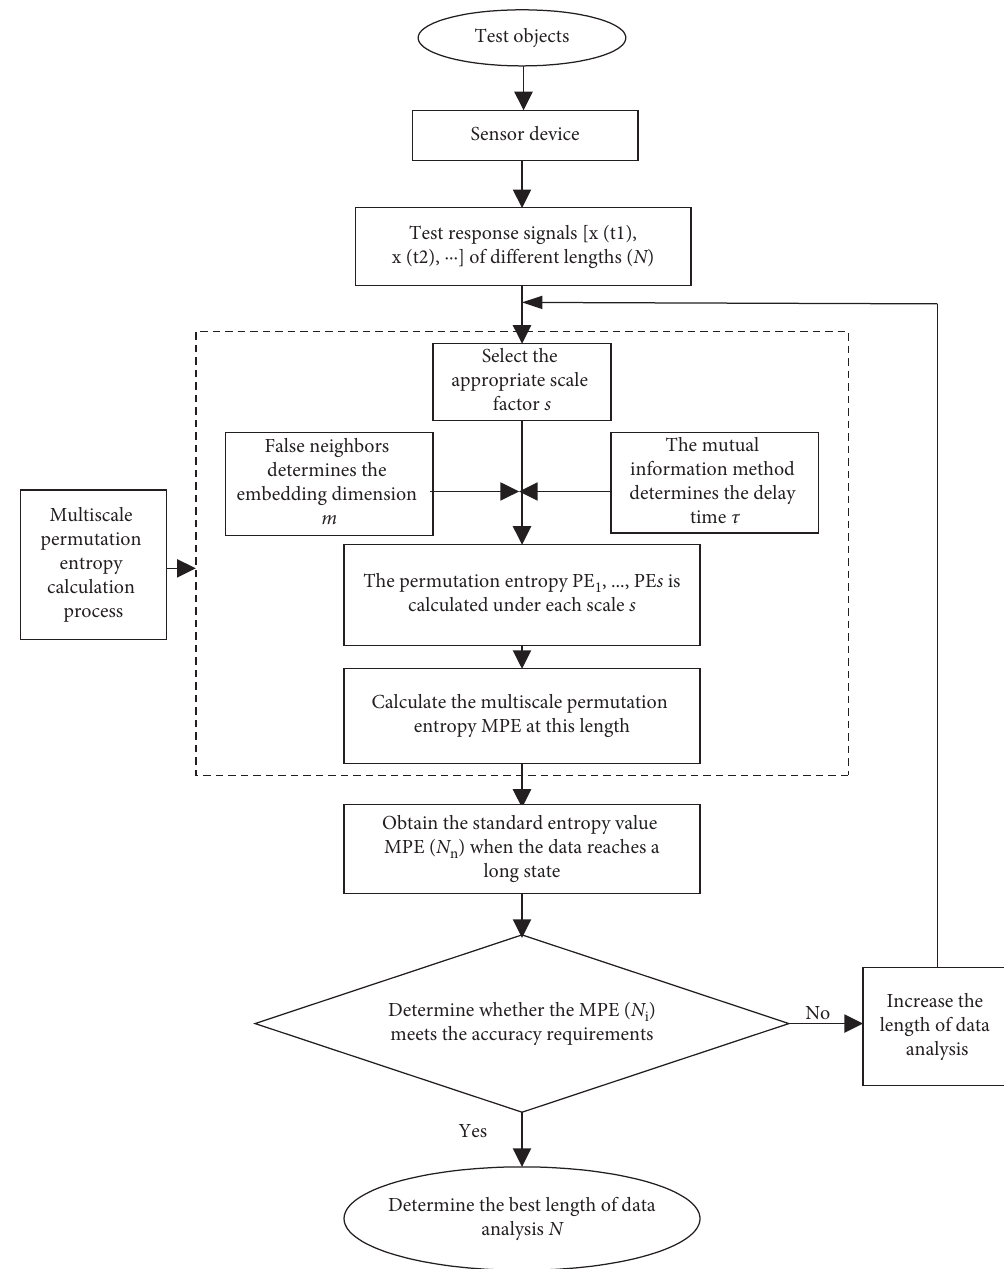
Figure 2: Flowchart of data length